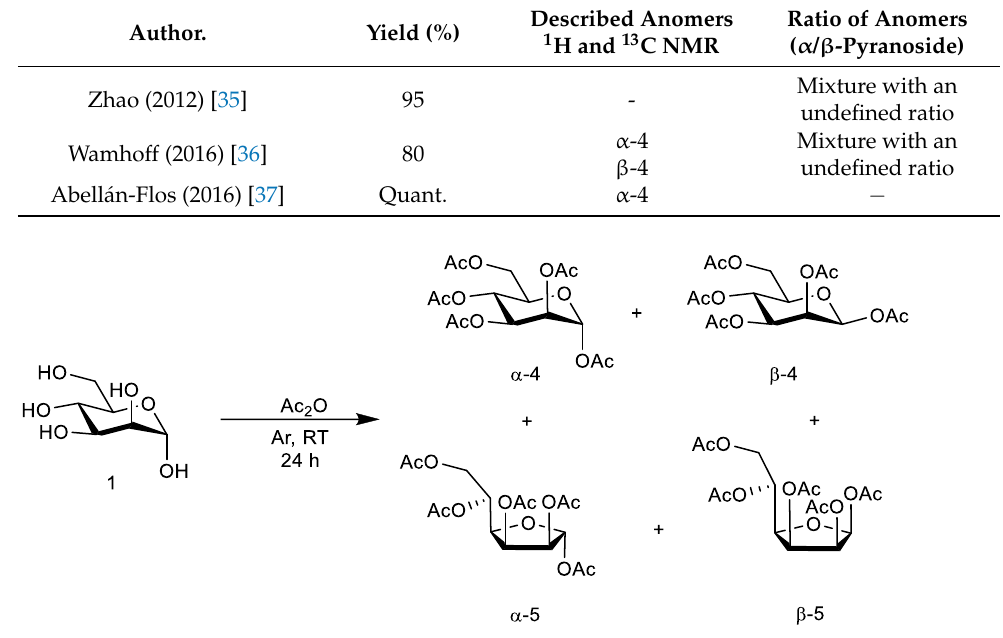
Table 2. Overview of papers where per- O -acetylation of mannose was performed. Yields of reactions, anomers, and their ratios are described.